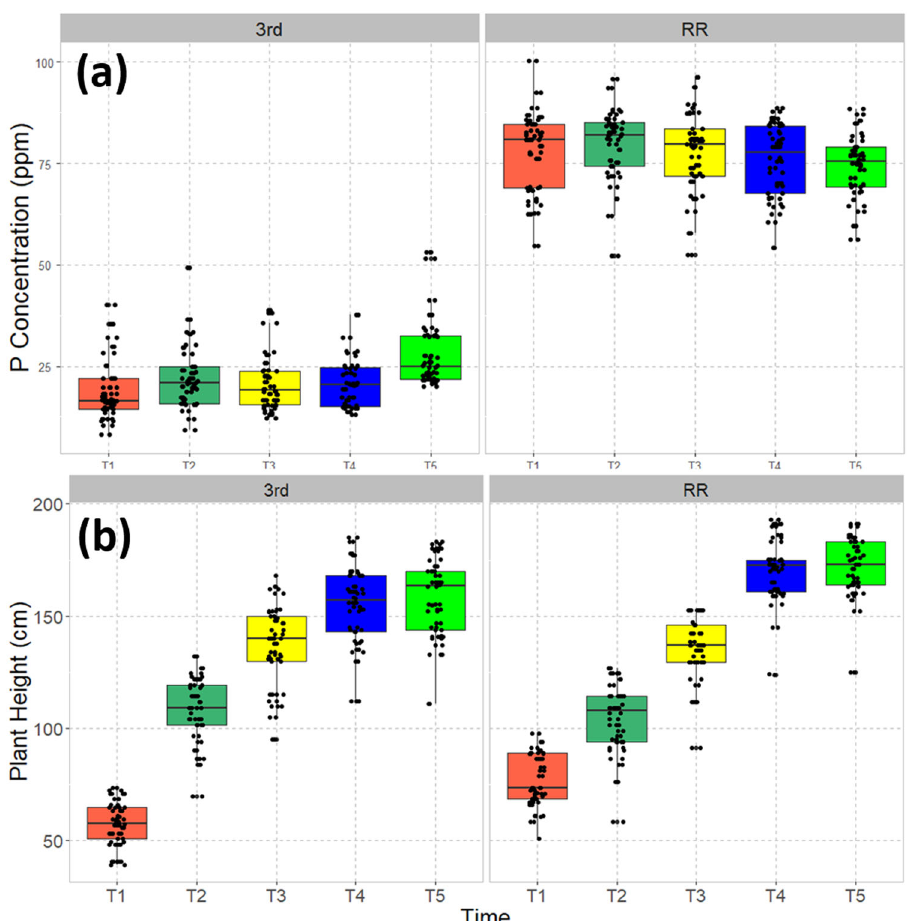
Fig. 2 Water-soluble P concentration and seasonal change in plant height. a The water-soluble P concentration in the soils at the two fi eld experiments at 3rd Street (silt loam soil) and Red River (sandy loam soil), respectively, with the boxes color-coded by the harvest times here and in subsequent fi gures. There was no signi fi cant difference in P concentration over the growing season at either location ( p = 0.892). Soil P concentrations are signi fi cantly higher at Red River ( p = 2.2 × 10 − 16 ). b The seasonal change of plant heights at the two fi eld